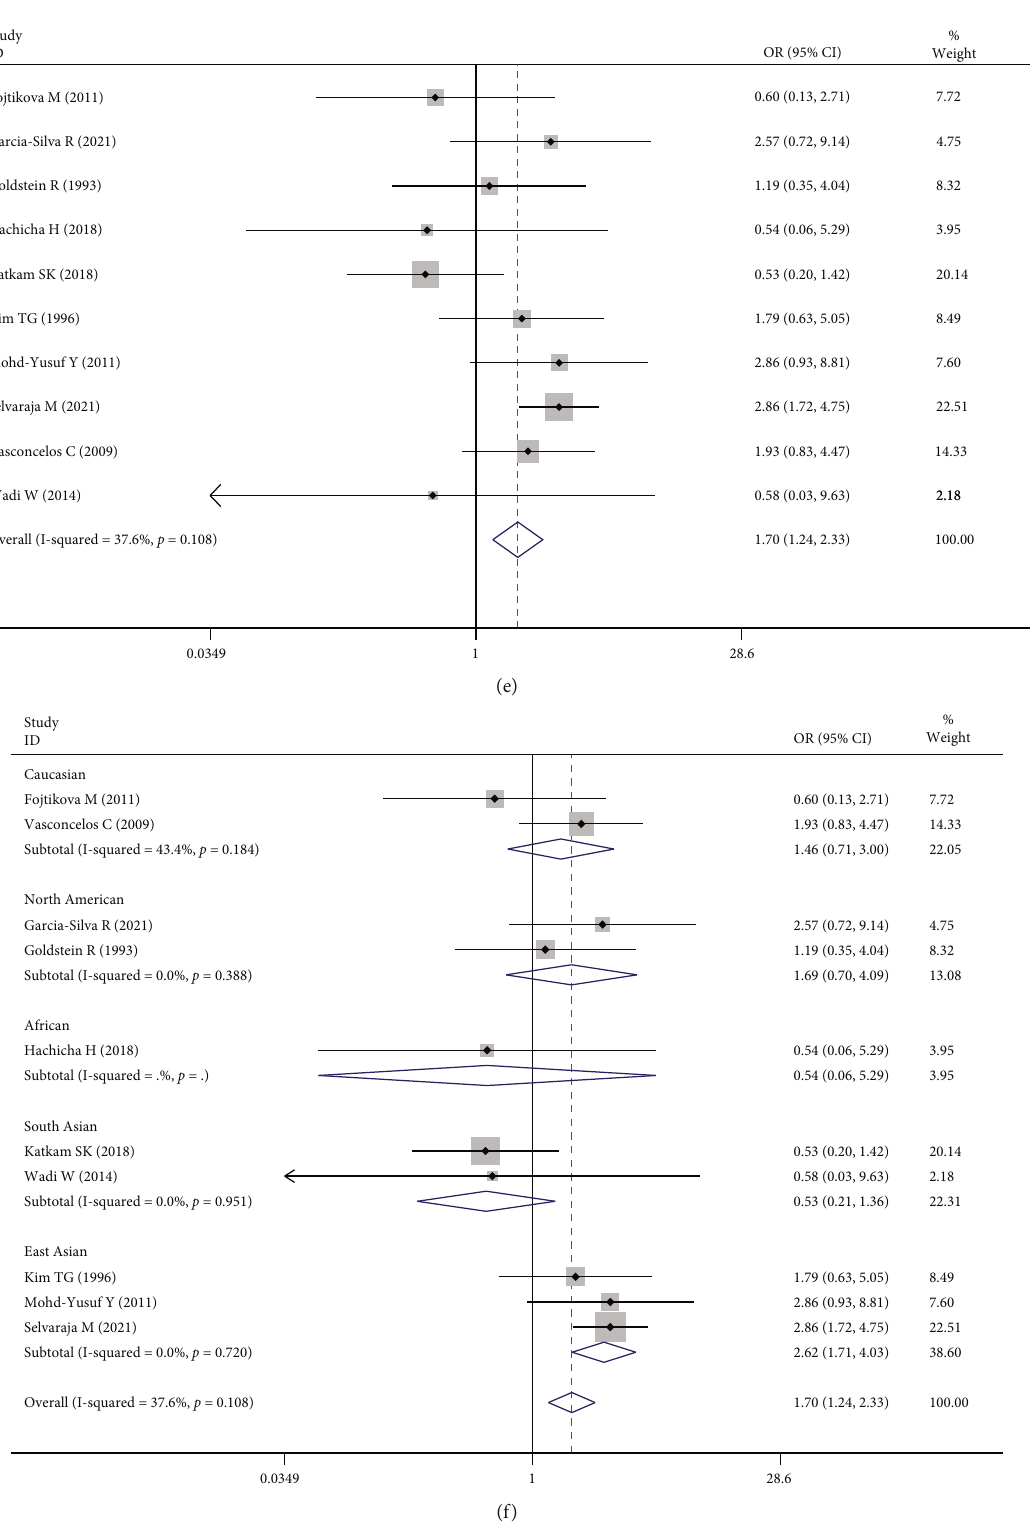
Figure 2: Forest plot of SLE risk associated with HLA-DRB1 polymorphisms in this meta-analysis. (a) Overall analysis of SLE risk associated with HLA-DR1 polymorphism. (b) Subgroup analysis (ethnicity) of SLE risk associated with HLA-DR1 polymorphism. (c) Overall analysis of SLE risk associated with HLA-DR13 polymorphism. (d) Subgroup analysis (ethnicity) of SLE risk associated with HLA-DR13 polymorphism. (e) Overall analysis of SLE risk associated with HLA-DR16 polymorphism. (f) Subgroup analysis (ethnicity) of SLE risk associated with HLA-DR16